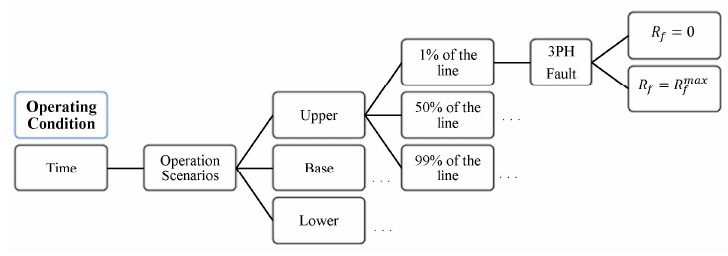
Figure 5. Definition of the set of fault scenarios for robust optimization procedure.